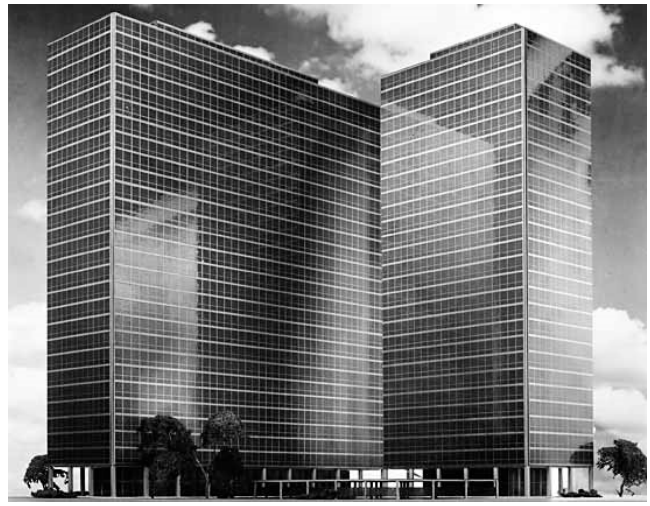
Figure 1. Mies van der Rohe Lakeshore Drive Apartment Building, 1955. The icon of International Style with modular repetitions and broad abstractions.